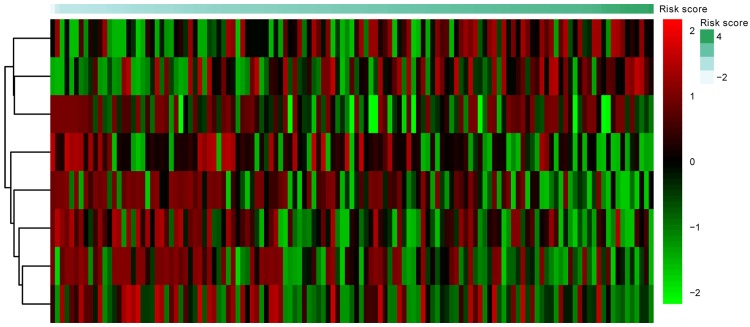
The clustering analysis map of methylation value in the DNA methylation signature sites.Diagram presents the result of a two-way hierarchical clustering of DNA methylation sites and risk score. The clustering is constructed using the complete-linkage method together with the Euclidean distance. Each row represents a DNA methylation site, and each column, a risk score value. The risk score clustering tree is shown on the right. The colour scale illustrates the relative value of the risk score: red, below the reference channel; green, higher than the reference.